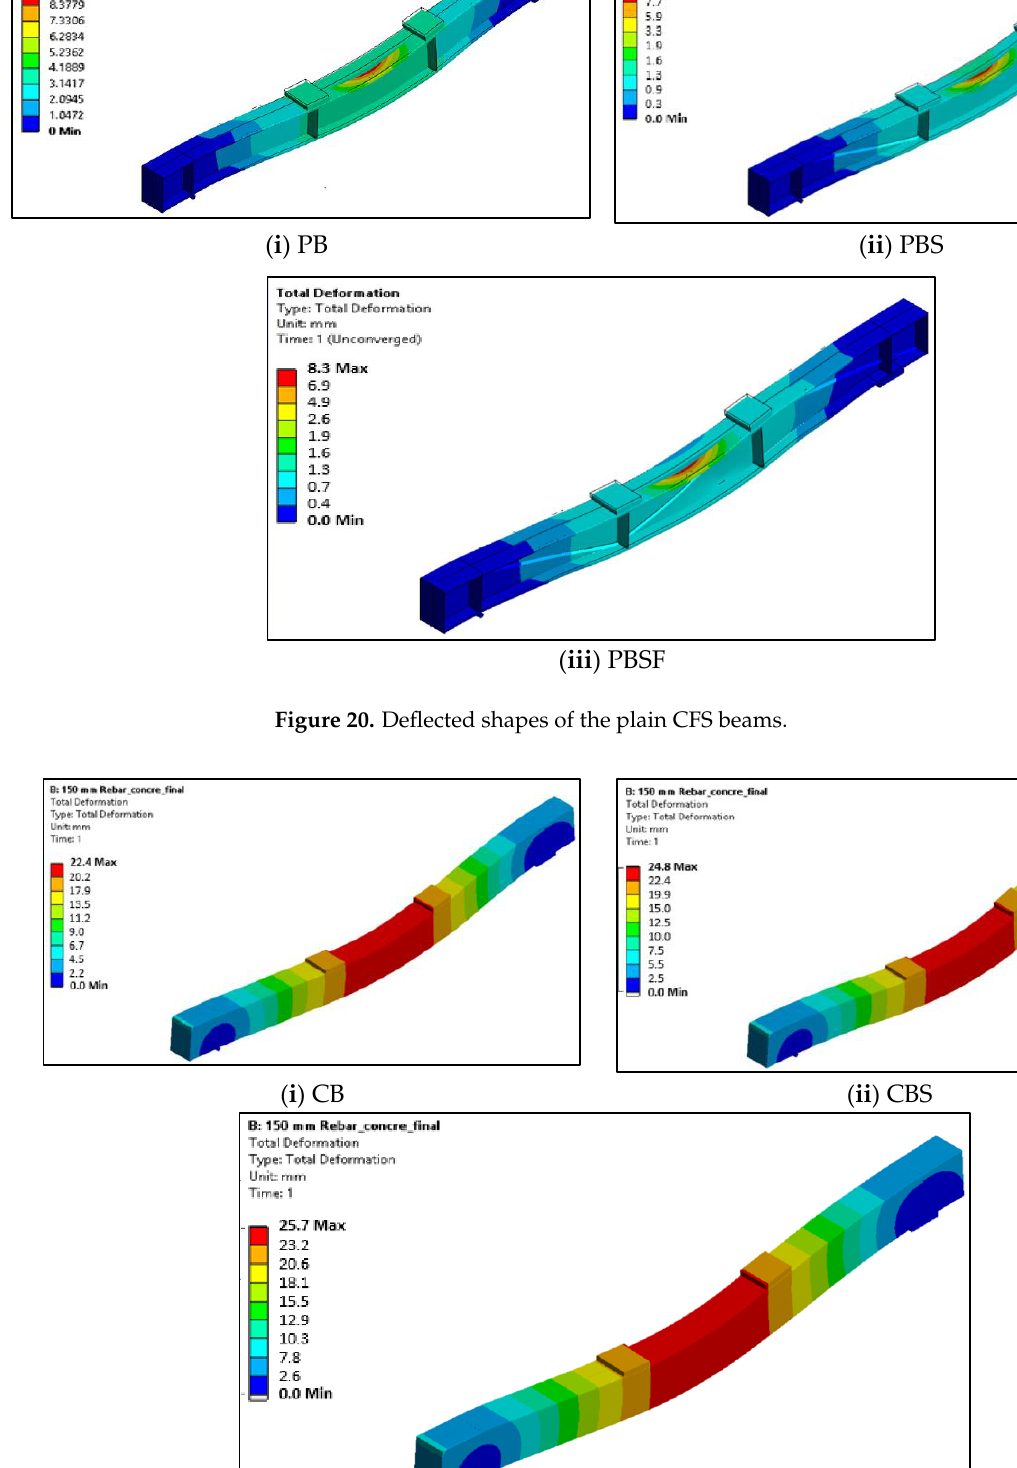
Figure 21. Deflected shapes of the composite CFS beams.